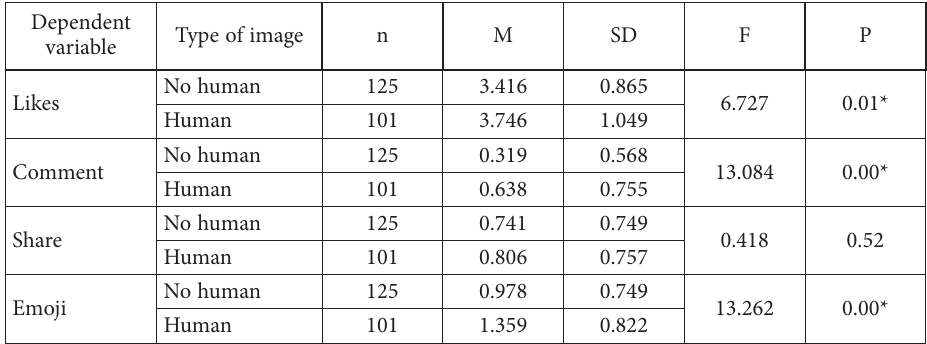
Table 2. ANOVA analysis for the effect of image type (n = 226)